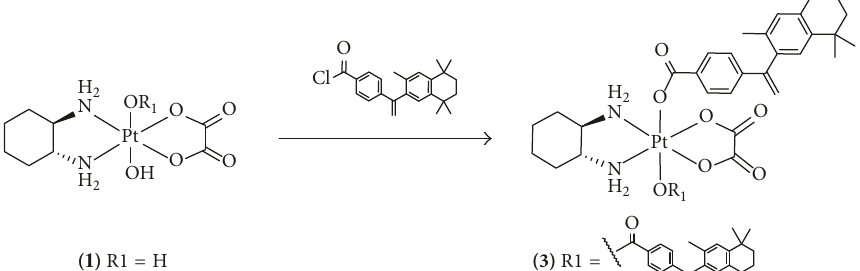
Scheme 3: Synthesis of Pt(IV) complexes.